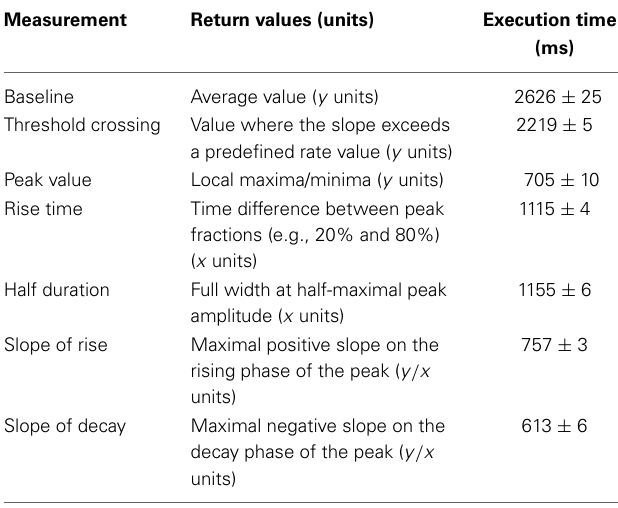
Table 2 | Description of principal